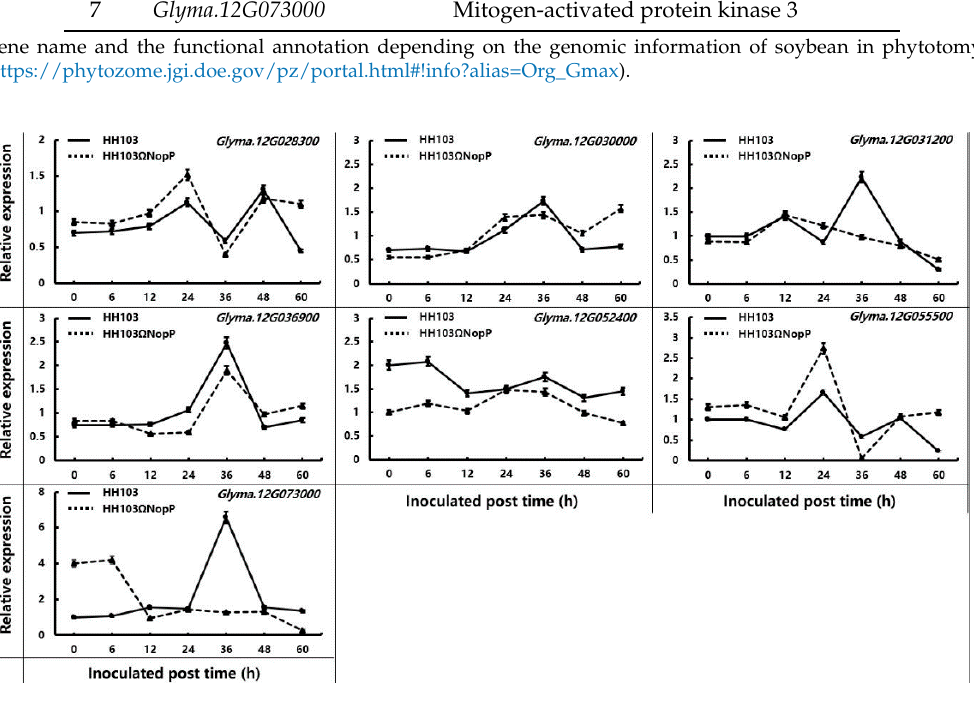
Figure 4. Relative expression levels of Glyma.12g028300, Glyma.12g030000, Glyma.12g031200, Glyma.12g036900, Glyma.12g052400, Glyma.12g055500 and Glyma.12g073000 in soybean roots after being independently inoculated with Ensifer fredii HH103 and Ensifer fredii HH103 Ω NopP in ‘Charleston’, and non-inoculated plants as the control. The expression levels of target genes relative to the control samples at corresponding time points were calculated using the 2 −ΔΔ C t method. Bars represent the mean ± SE (standard error) of three replications. Different letters represent significant differences ( p ≤ 0.05) at each time point based on Duncan’s multiple range test.